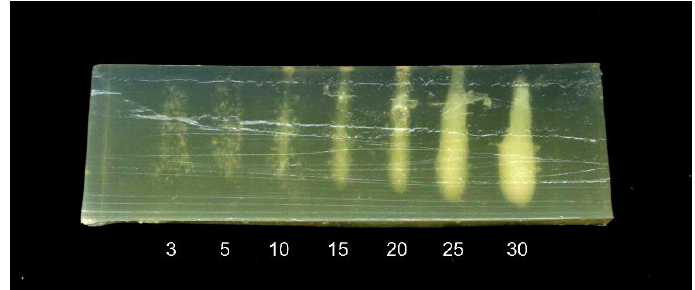
Figure 5. HIFU phantom treated with a 1 MHz transducer at 55 mm distance, for 3–30 s (treatment time marked below each treatment position). The phantom was at room temperature prior to treatment. The horizontal stripes in the image are due to imperfect cutting of the phantom slice.